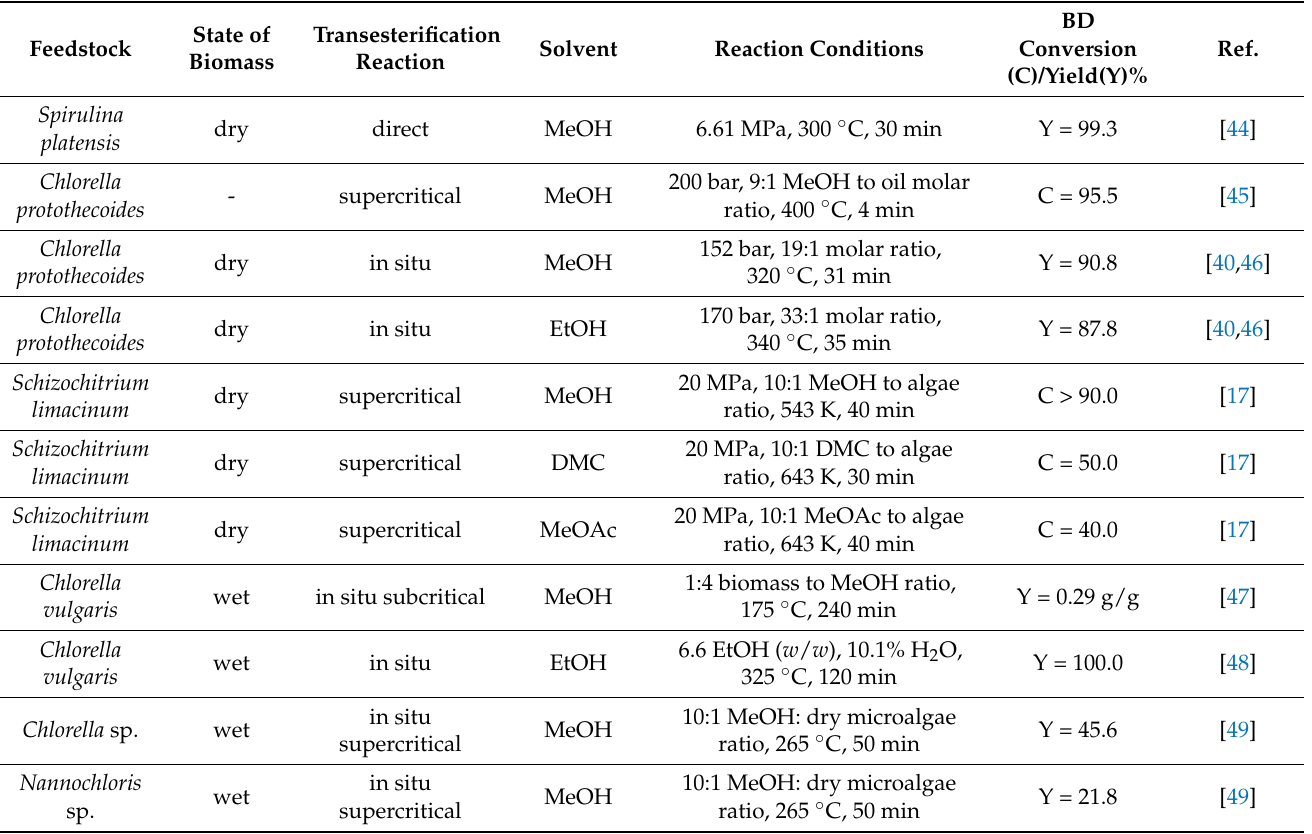
Table 1. Non-catalytic transesterification into